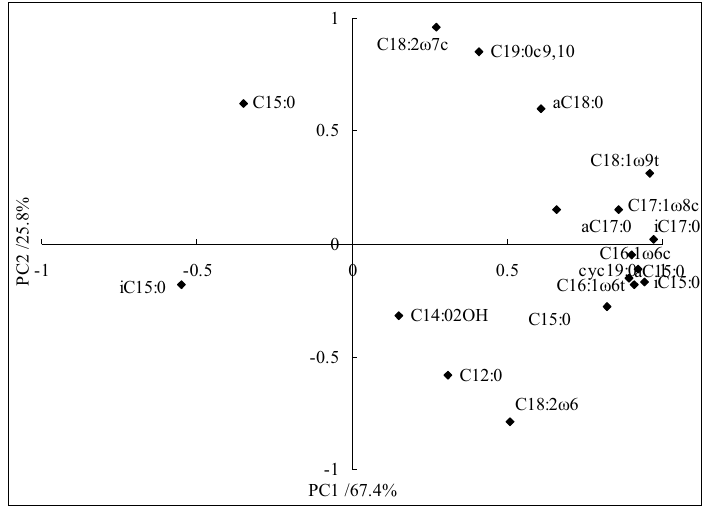
Figure 3. PCA of loading value for individual phospholipids fatty acids with different tillage treatments.